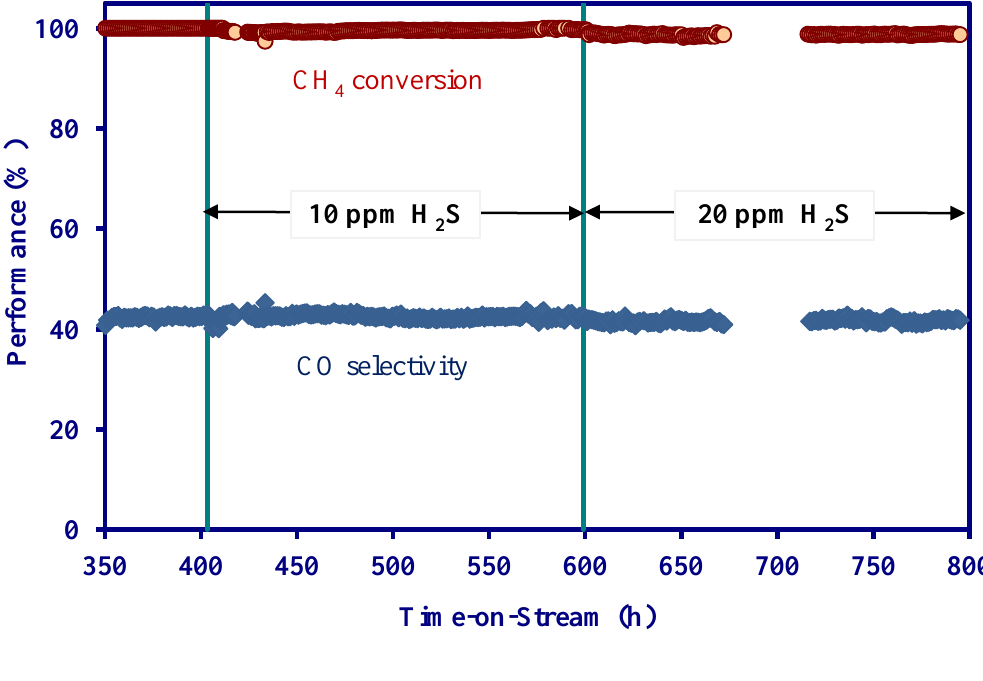
Figure 4. Effect of H S on catalytic performance of MNS catalyst under the conditions of 2 900 °C, 3.7% H , 8.4% CO, 13.8% CO 2 H S (when used), and GHSV = 24,000 2